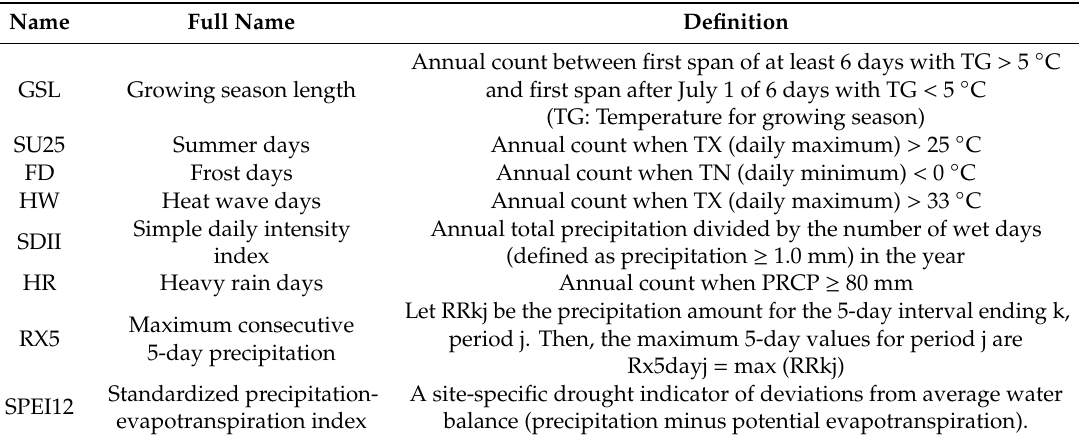
Table 1. List of climate extreme